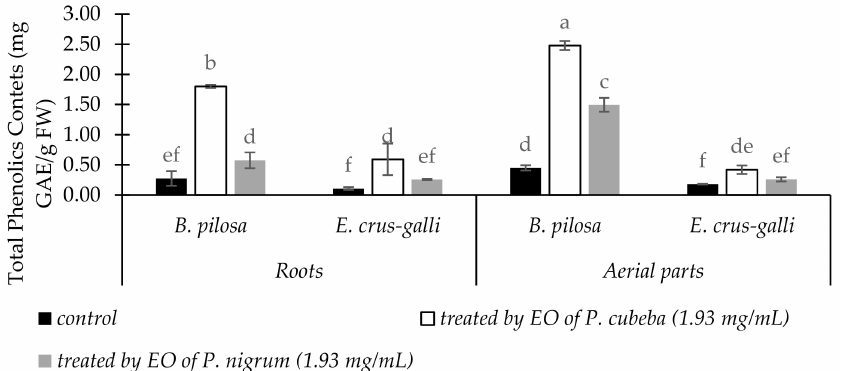
Figure 4. The changes of TPC in the roots and aerial parts of between treated and untreated of B. pilosa and E. crus-galli by P. cubeba and P. nigrum EOs. Data were presented in means ± standard deviations (SD). Means with di ff erent small letter indicted significantly di ff erent by Fisher’s test ( p <